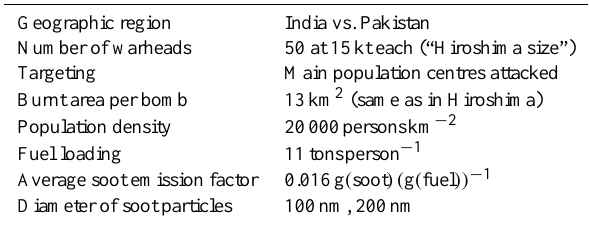
Table 1. Summary of assumed soot emission scenario (same as in Toon et al.,